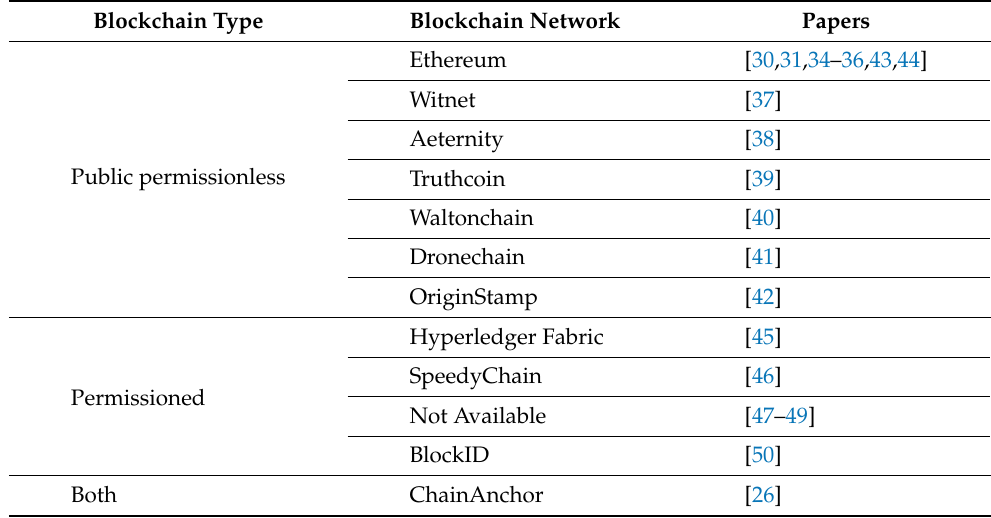
Table 2. Blockchain